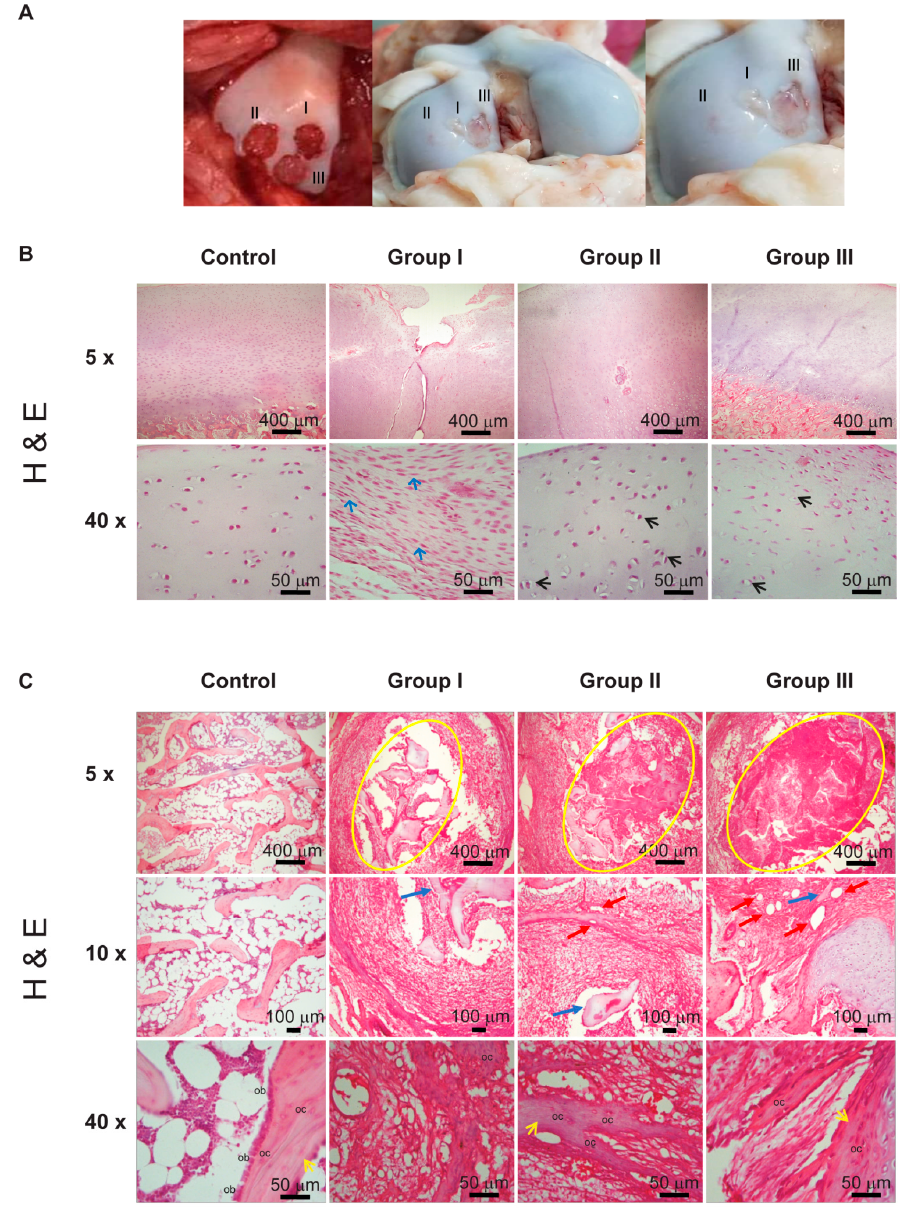
Figure 6. CartilagegrossappearanceandH&Estainingat8weekspost-transplantation. ( A )Representative images of the gross appearances at 8 weeks after operation. Numbers I, II and III indicate the location of the implants: monophasic, biphasic and cellularized only in the chondral phase, and biphasic and cellularized in both phases, respectively. ( B ) Representative histological images of the repaired chondral area analyzed by H&E at 8 weeks after implantation. In the panoramic image (5 × ), the degree of filling of the lesion is appreciated, while the 40 × magnification evidenced a hierarchical organization similar to the control, where in Groups II and III the presence of lacunae with characteristic spherical chondrocytes (black arrows) can be observed. In contrast, in Group I there is abundant filling tissue, predominantly of cells with a fusiform morphology similar to that of fibroblast cells (blue arrows). ( C ) The area enclosed within the yellow line represents the bone repair area. Groups I, II and III show an adequate integration with adjacent tissue; we noted the presence of osteoblasts (ob) as well as osteocytes (oc) embedded in the bone matrix, with the formation of blood vessels (red arrows) as well as fibroin residues (blue arrows). The groups treated with biphasic sca ff olds showed a better cellular and tissue organization compared to the control, highlighting in Group II the presence of trabeculae (yellow